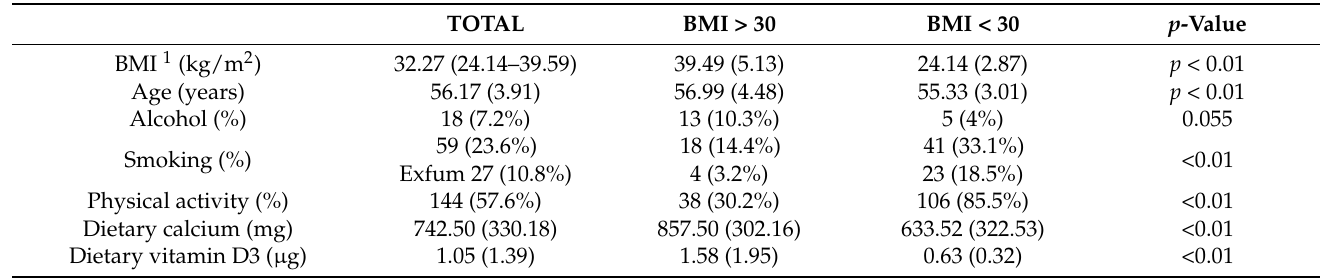
Table 1. Differences between the presence or absence of obesity in variables than may affect in bone metabolism.